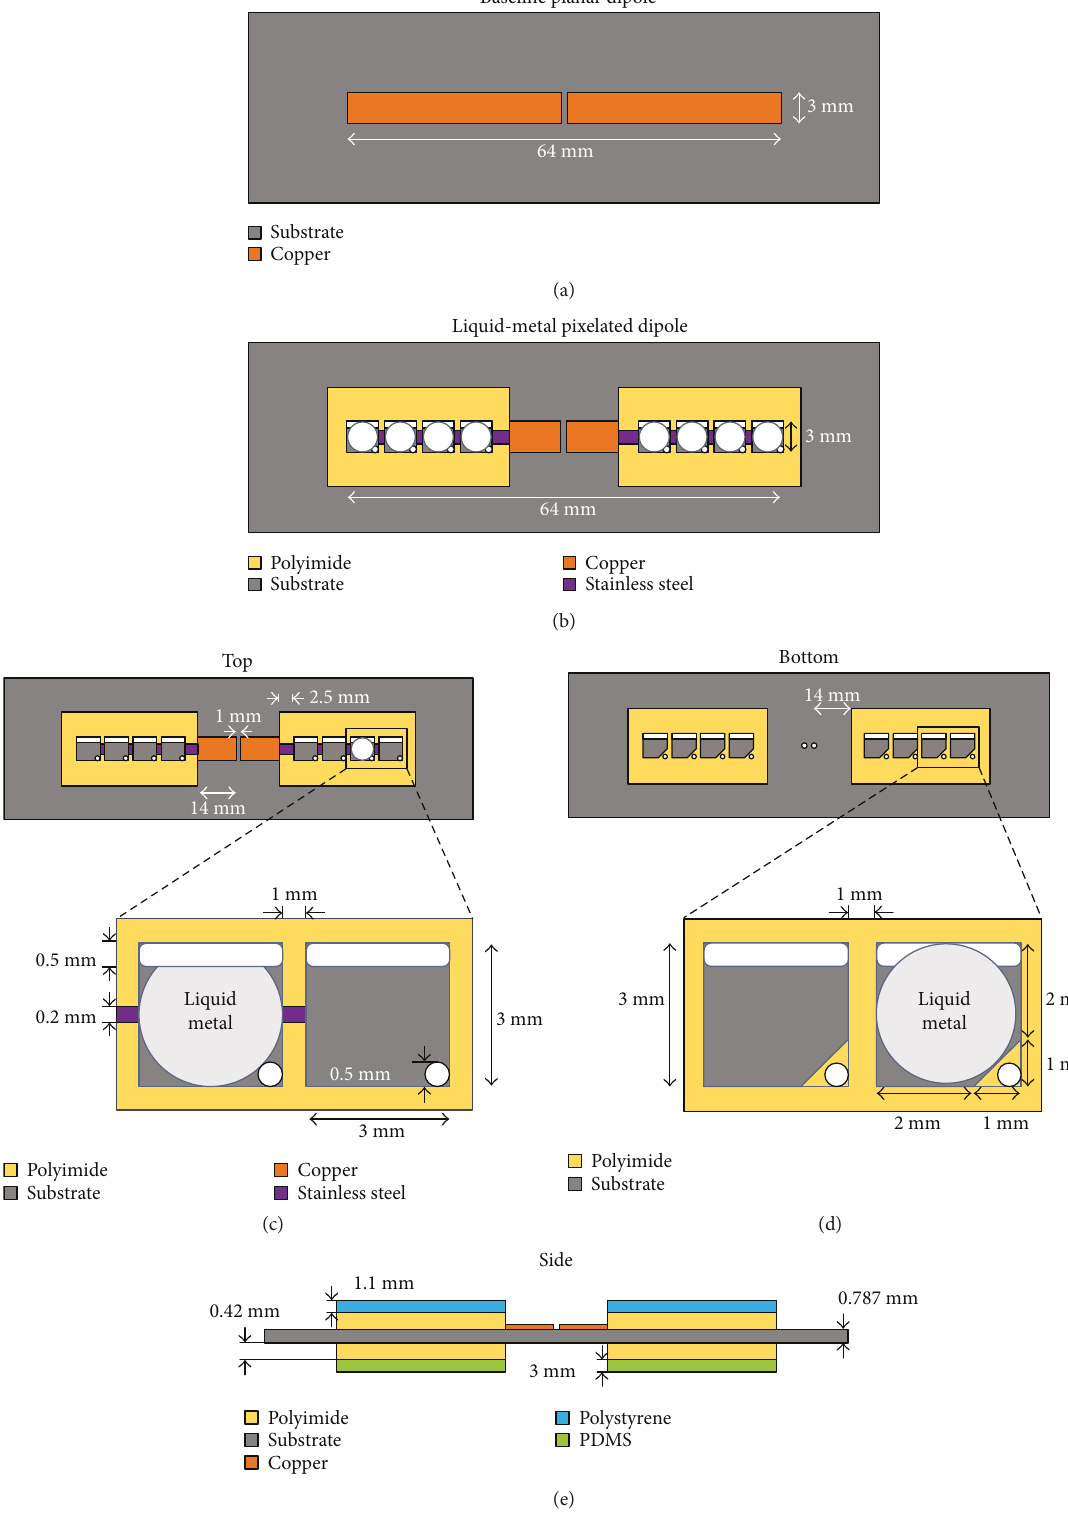
Figure 1: (a) Baseline planar dipole antenna to compare to liquid-metal pixelated equivalent. (b) Liquid-metal pixelated dipole prototype fi lled with liquid metal. (c) Top side with zoom-in of pixels. The left pixel is in the “ on ” state, with liquid metal present and interfacing with stainless steel placed within the walls between pixels. (d) Bottom side with zoom-in of pixels. The right pixel is in the “ o ff ” state. (e) Side